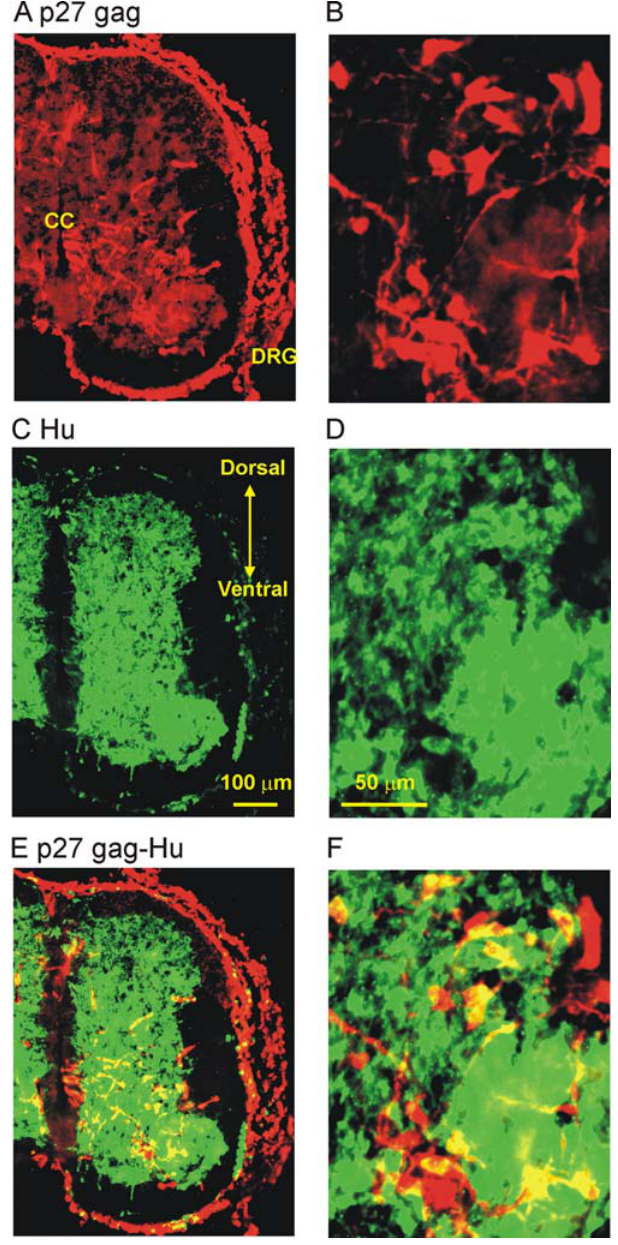
Figure 2. Immuno-labeling of chicken spinal cord for the viral gag p27 protein and the neuronal marker Hu. A) RCASBP(B)-Kir2.1 infected embryos show significant expression of viral p27 gag throughout the spinal cord. C) Hu staining is found mainly in the gray matter area of the spinal cord and in the DRG. E) Superimposed images from A and C showing double staining of spinal cord neurons with gag p27 viral protein and Hu. B,D,F) Higher magnification image of the ventral spinal cord for the sections represented in A,C,E, respectively. In these experiments, chicken embryos were infected with RCASBP(B)- Kir2.1 at E2. Embryos were allowed to develop until E8 before tissue isolation and sectioning. RCASBP(B)-Kir2.1 infected chicken embryos, blockade of ongo- ing activity does not result in a statistically significant change in the number of Islet -positive neurons compared with RCASBP(B)- infected embryos (RCASBP(B) = 17907 6 1377 vs. RCASBP(B)-